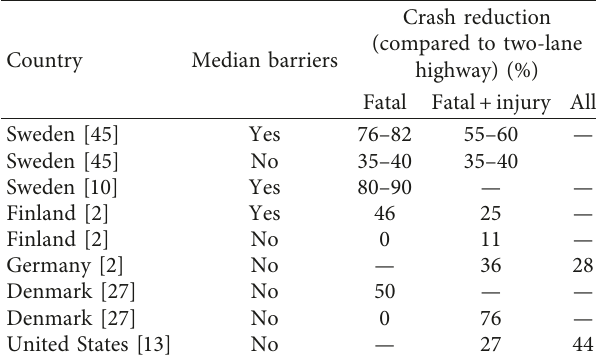
Table 5: Comparison of international 2+1 road safety performance.